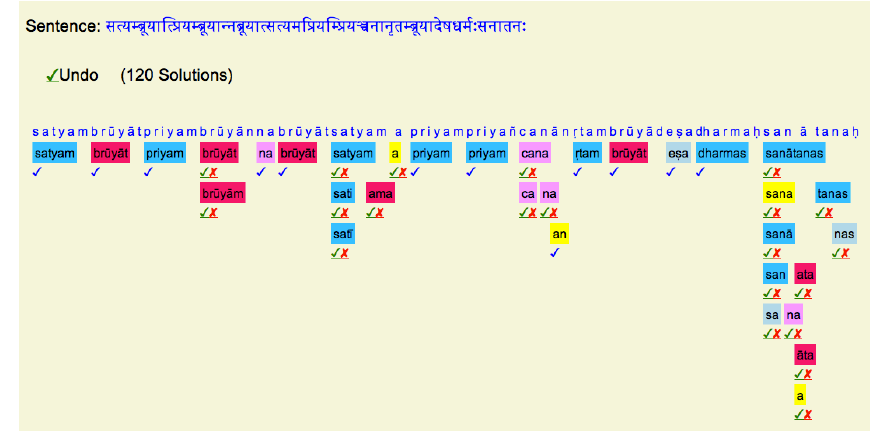
Figure 1: Initial display of the aligned segments for the sentence satyaṃbrūyātpriyaṃbrūyānnabrūyātsatyamapriyaṃpriyaṃcanānṛtambrūyādeṣa-